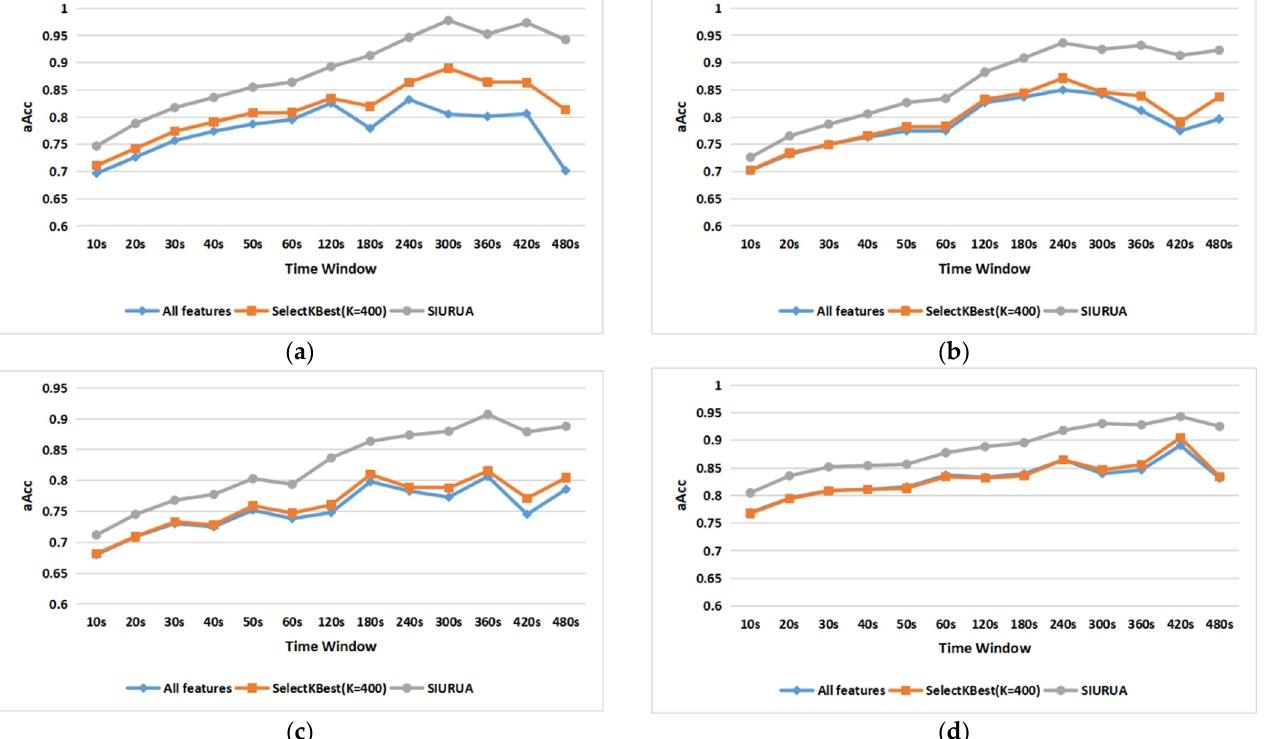
Figure 11. ( a ) Comparison of accuracy between SIURUA and the selection of 400 best features in a typing scene; ( b ) comparison of accuracy between SIURUA and the selection of 400 best features in a Taobao scene; ( c ) comparison of accuracy between SIURUA and the selection of 400 best features in a Weibo scene; ( d ) comparison of accuracy between SIURUA and the selection of 400 best features in a gaming scene.